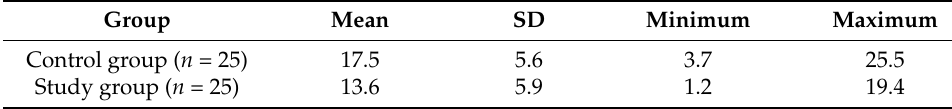
mean angle of 17.5 ◦ and a standard deviation of 5.6 ◦ . In the study group, the forehead inclination ranged from 1.2 to 19.4 ◦ with a mean of 13.6 ◦ and a standard deviation of 5.9 ◦ . The difference between the groups was significant ( p < 0.05, Table 4). Table 4. Forehead inclination (angle between lines 3 and 1, °). Table 4. Forehead inclination (angle between lines 3 and 1, ◦